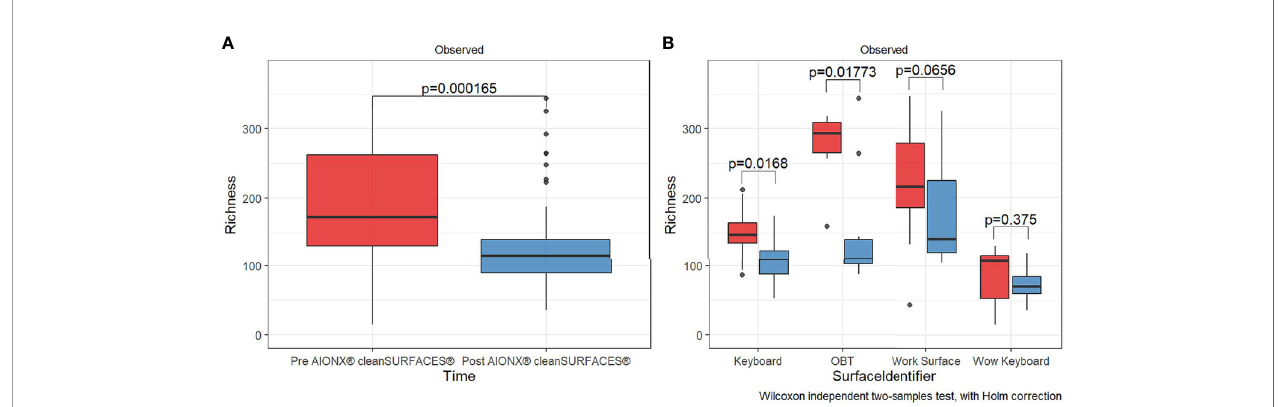
FIGURE 3 | Alpha diversity box plot compares observed taxonomic richness between surface swabs collated before [red] and after [blue] the intervention of AIONX ® cleanSURFACES ® . Overall, a signi fi cant decrease [Wilcoxon rank sum Holm adj. p = 0.000165] in transcriptionally active microbial taxa was observed after the intervention of AIONX ® cleanSURFACES ® (A) . When partitioned by surface (B) , we observed signi fi cant decreases in taxonomic richness after the intervention of the AIONX ® cleanSURFACES ® on the Keyboard, OBT, and Work Surface [Wilcoxon rank sum Holm adj. p < 0.05].